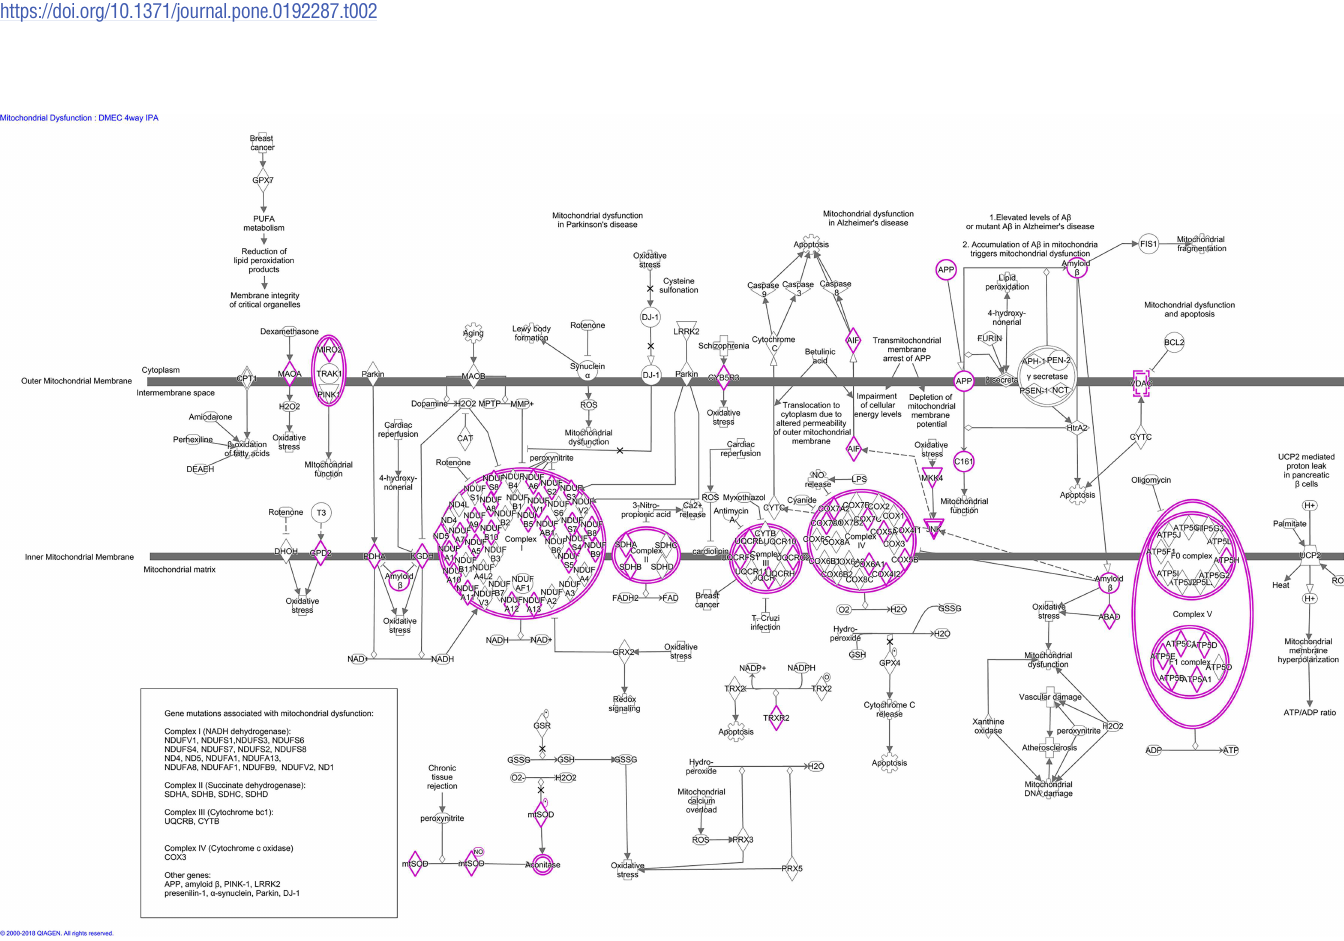
Fig 4. Overview diagram of differentially expressed human EDM proteins in increasing severity of diabetes mellitus involved in oxidative phosphorylation. All proteins in the diagram highlighted in pink were altered statistically relative to increasing disease severity. Oxidative phosphorylation and mitochondrial dysfunction were the two most affected cellular mechanisms during the progression of diabetes mellitus type II in EDM tissues. Figure were created using IPA (Qiagen, Germantown, MD).